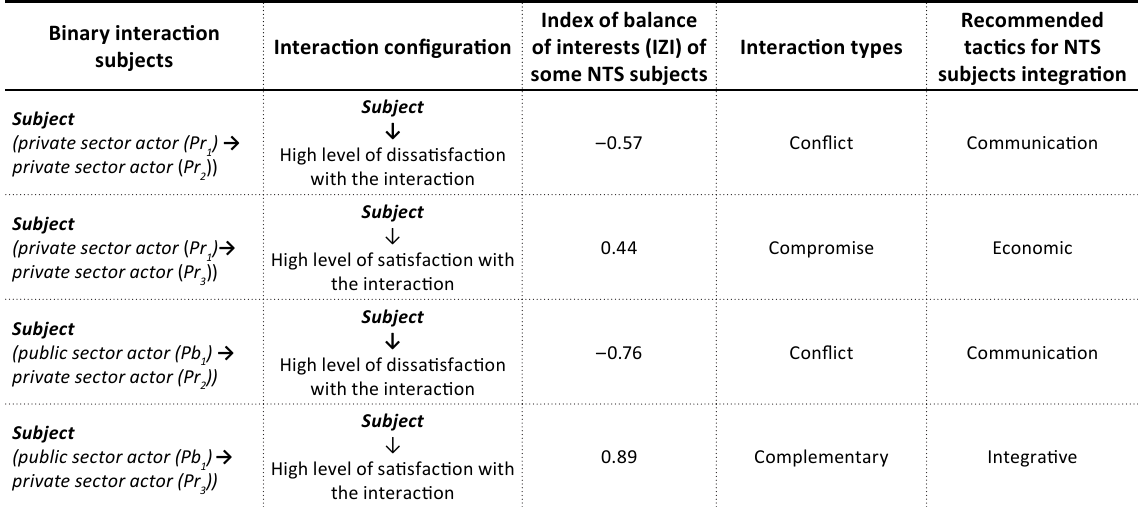
Source: Developed by the